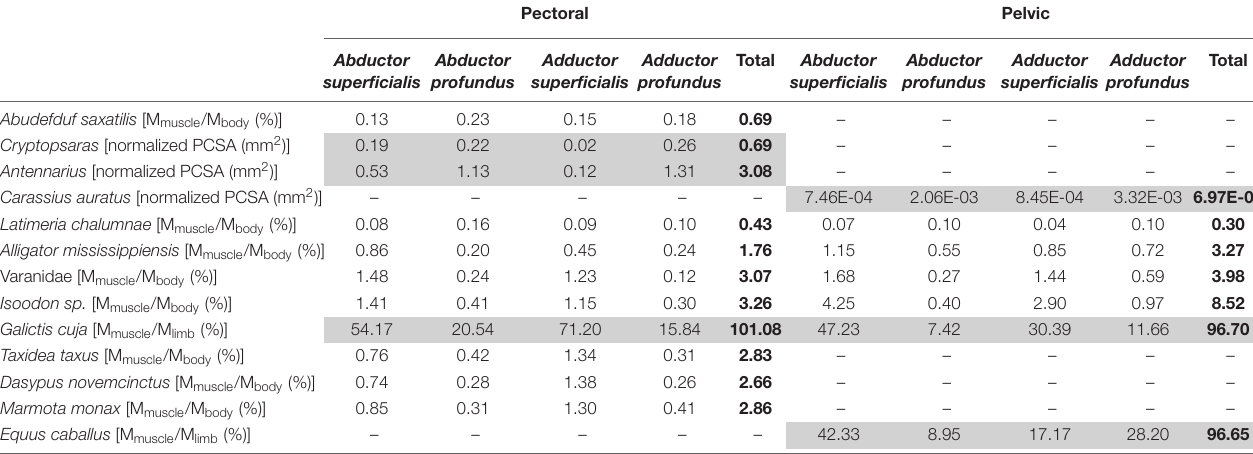
TABLE 1 | Distribution of the muscle groups of the pectoral and pelvic